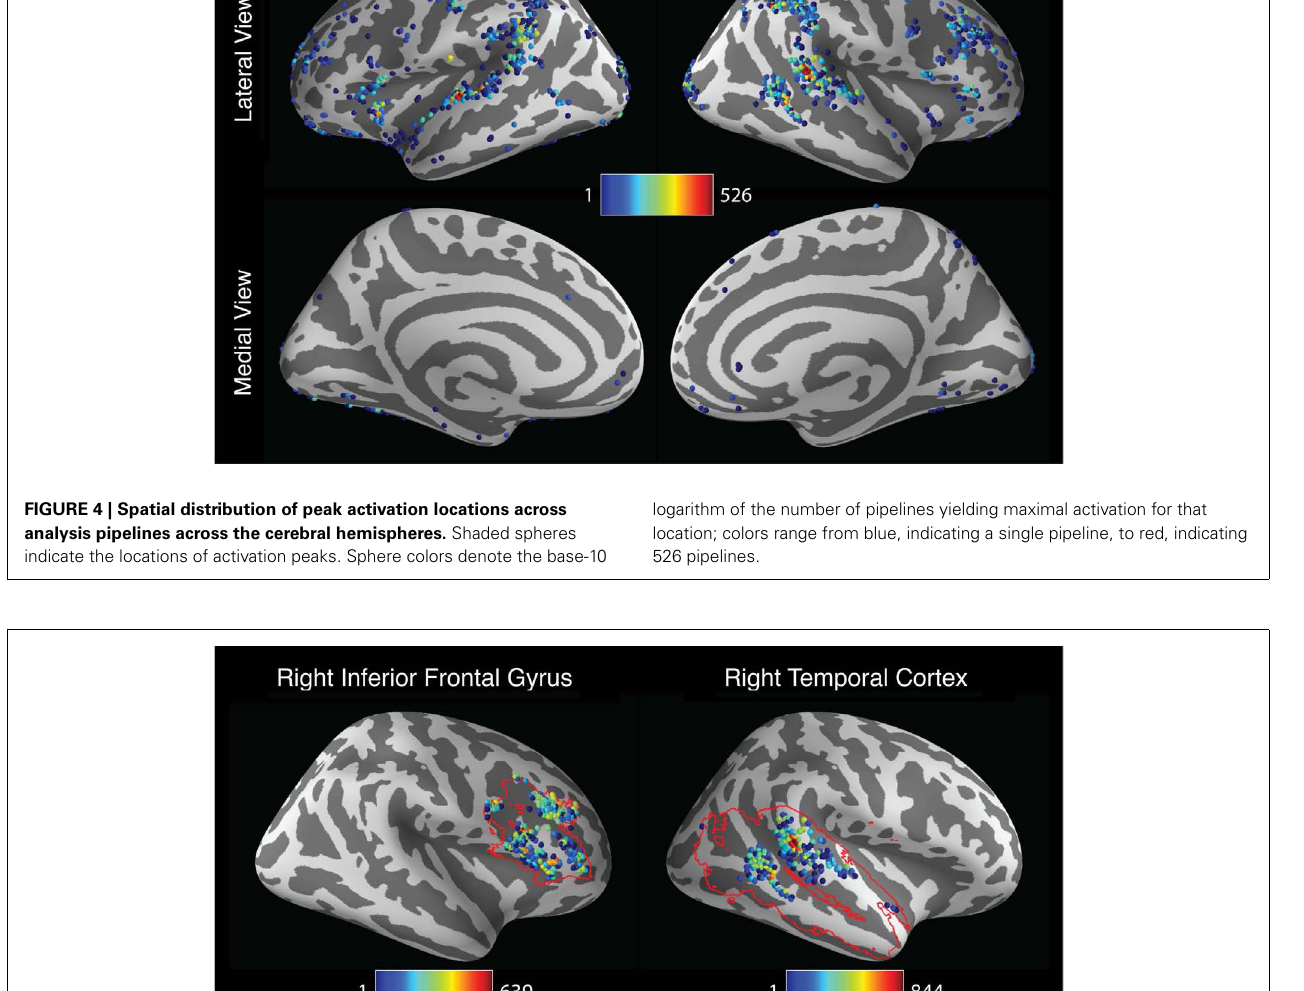
FIGURE 5 | Spatial distribution of peak activation locations across analysis within anatomically defined regions of interest (ROIs). Red contour lines indicate the boundaries of the ROIs. All images represent lateral views of the right hemisphere. Shaded spheres indicate the locations of activation peaks. Sphere colors denote the base-10 logarithm of the number